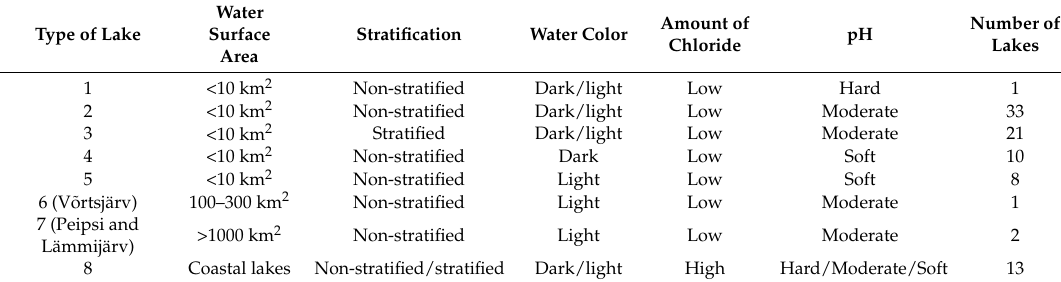
Table 1. Classification of Estonian lake types for applying the European Union Water Framework Directive (EU WFD) based ecological status class estimation. Water color “dark” means absorption at 400 nm is ≥ 4 m − 1 and water color “light” means absorption at 400 nm is <4 m − 1 . High Amount of Chloride means content of chloride in water >25 mg/L, and low amount means <25 mg/L. Hard water